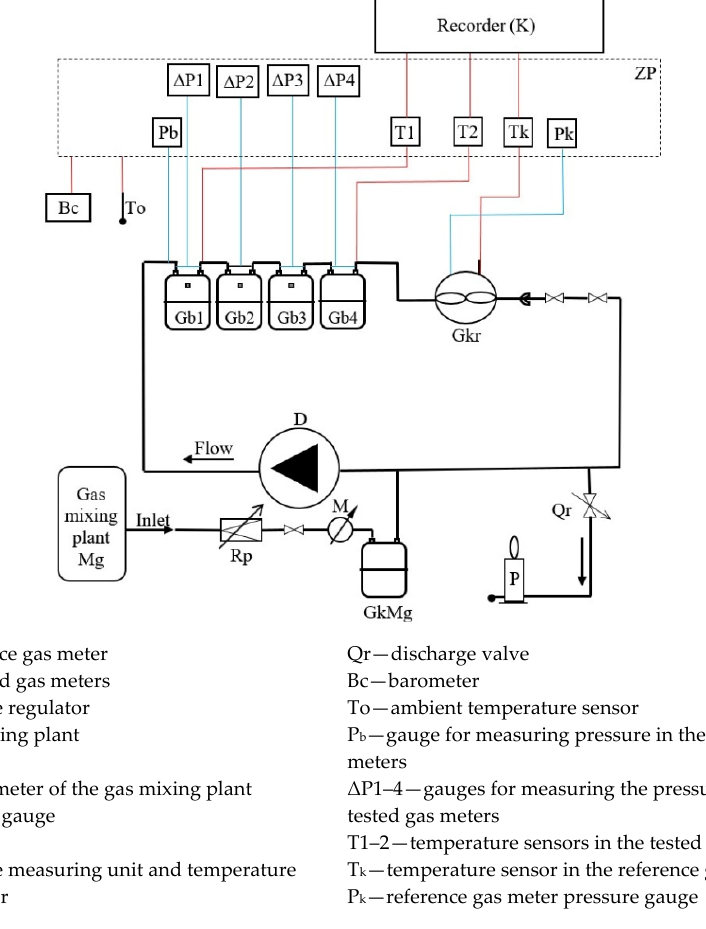
Figure 3. Diagram of the bench for testing the effect of gas composition changes on the errors of indications of gas meters. Energies 2020 , 13 , x